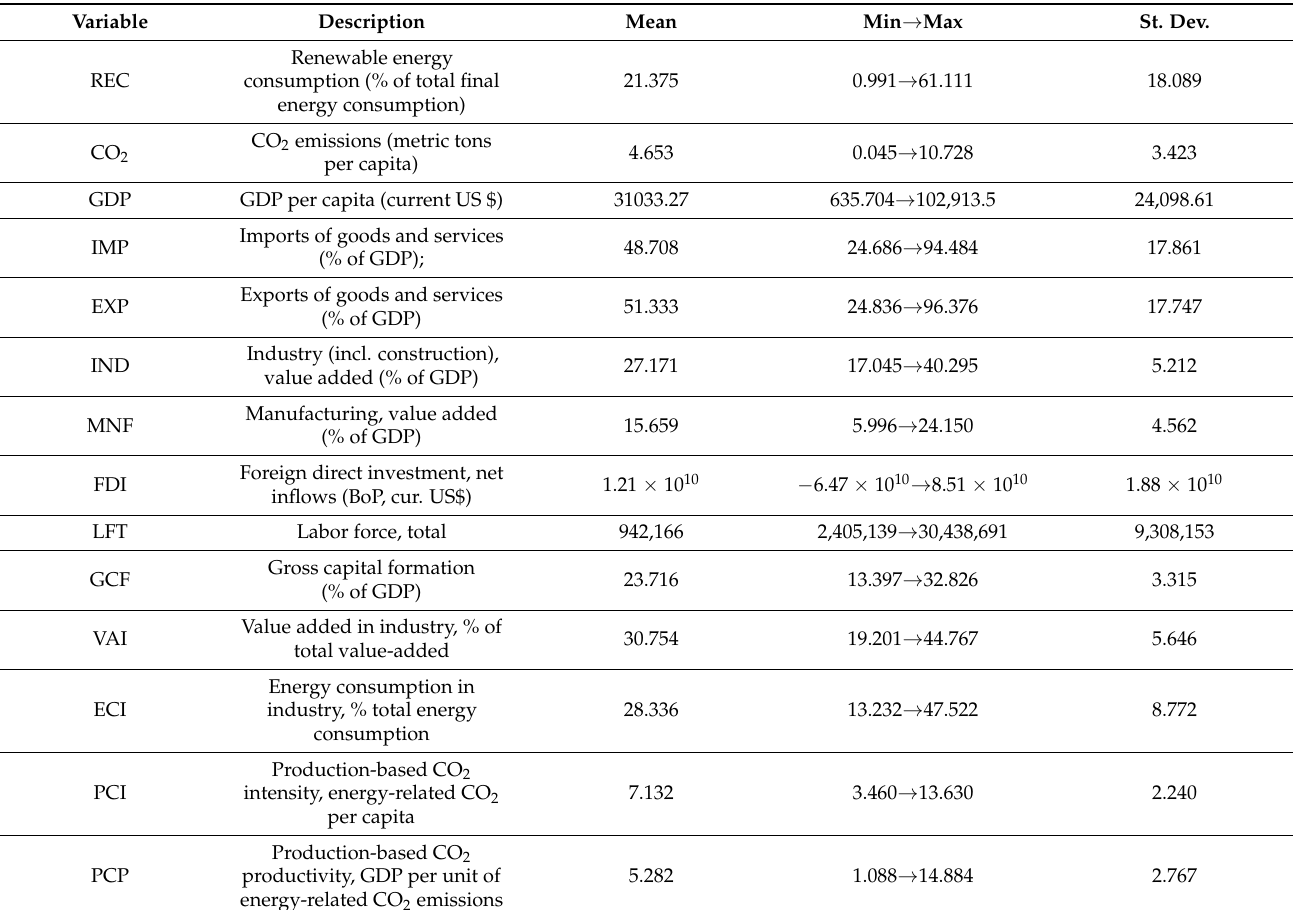
Table 2. Definitions of variables and descriptive statistics for all